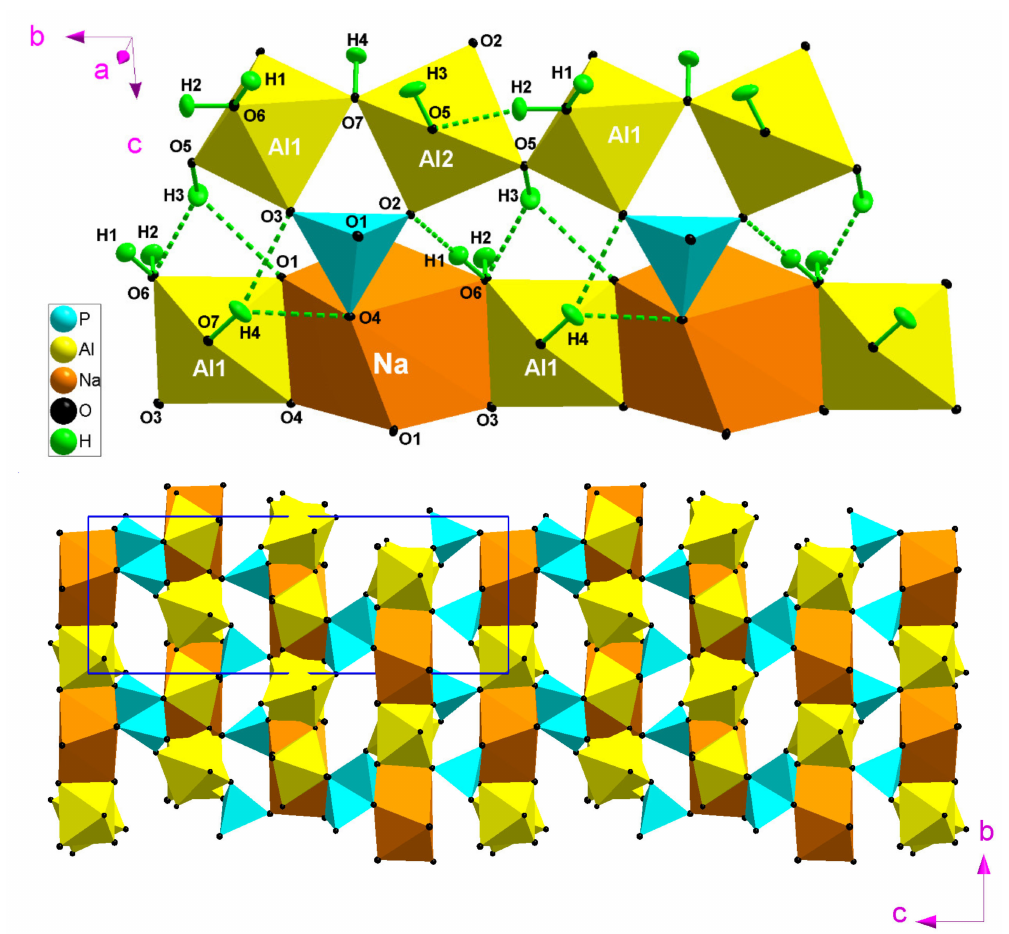
Figure 1. ( Bottom ) A view of the crystal structure of wardite down {100} (the unit-cell in blue). ( Top ) Details of the crystal structure and H-bonding network (based on the neutron structure refinement by Gatta et al. [4]). The structure of wardite contains hydroxyl groups and H 2 O molecules. Gatta et al. [4] reported that whereas the unique H 2 O molecule (i.e., H1-O6-H2) experiences two strong H-bonds, as corroborated ◦ by the bonding geometry (i.e., O6-H1 . . . O2 = 174.4(1) and H1 . . . O2 = 1.617(1) Å, O6-H2 . .